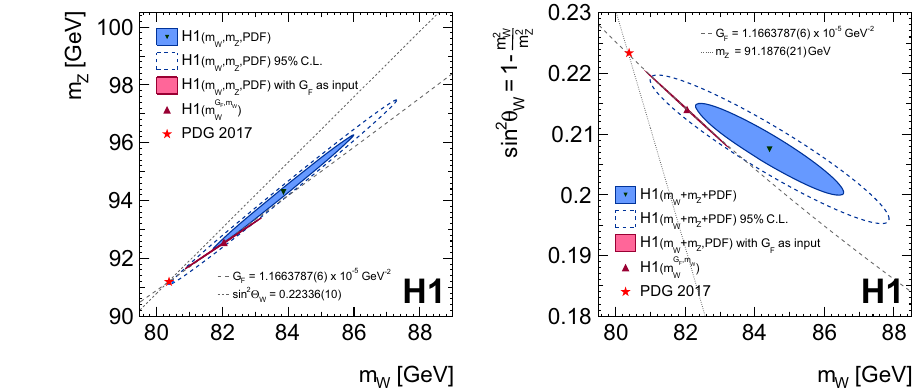
Fig. 3 Results of the m W + m Z +PDF fit, and the m W + m Z +PDF fit with G F as additional input. For better visibility, the right panel displays the quantity / m 2 sin 2 θ W = 1 − m 2 on the W Z vertical axis and identical results as the left panel. The 68% confidence level (CL) contour of the fit including the G F measurement is very